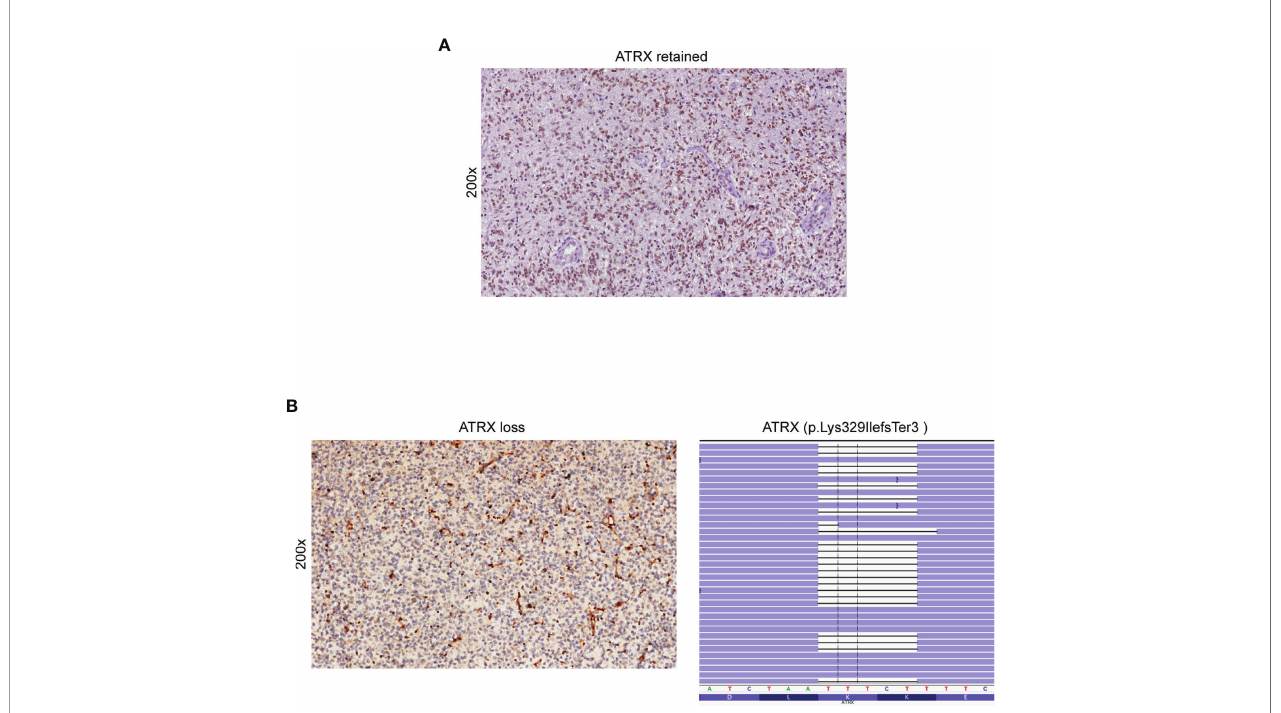
FIGURE 3 | Detection of ATRX loss by immunohistochemistry and NGS. (A) Retained nuclear expression of ATRX in neoplastic glioma cells (immunoperoxidase; original magni fi cation 200x). (B) Loss of nuclear expression of ATRX in a sample of astrocytoma (case 49) (left panel). Note the retained immunoreactivity in endothelial cells and non-neoplastic entrapped glial cells (immunoperoxidase; original magni fi cation 200x). NGS demonstrated the presence of the ATRX p. Lys329IlefsTer3 truncated mutation (case 49) (right panel). Results were viewed in the